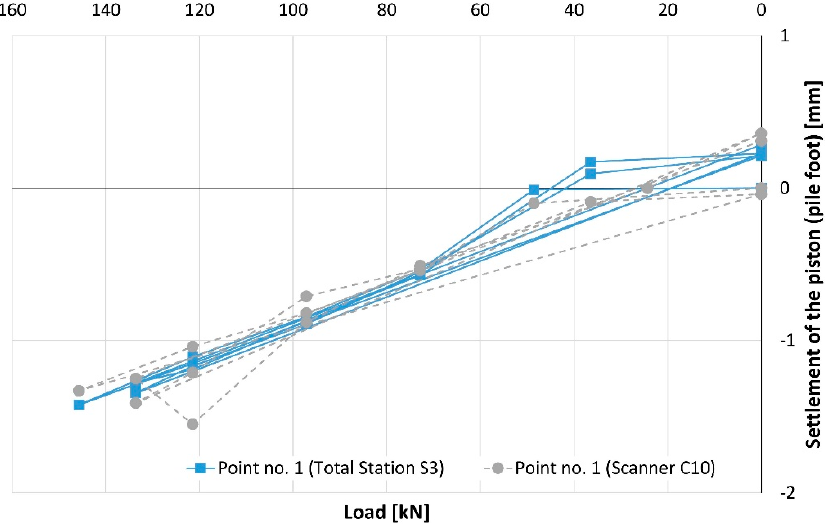
Figure 9. The settlement of the piston (pile foot) represented by point no. 1.